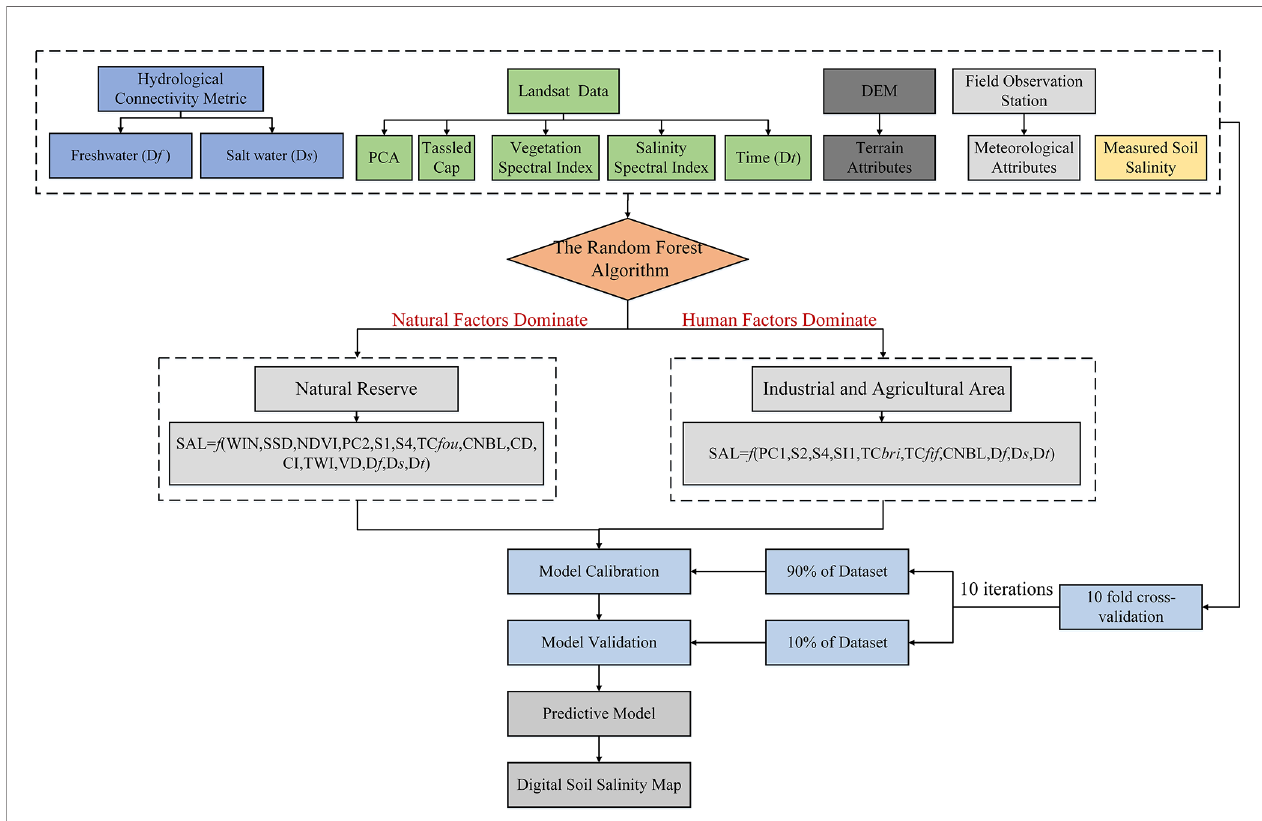
FIGURE 3 | Flow chart of the methodology used for soil salinity estimation in this